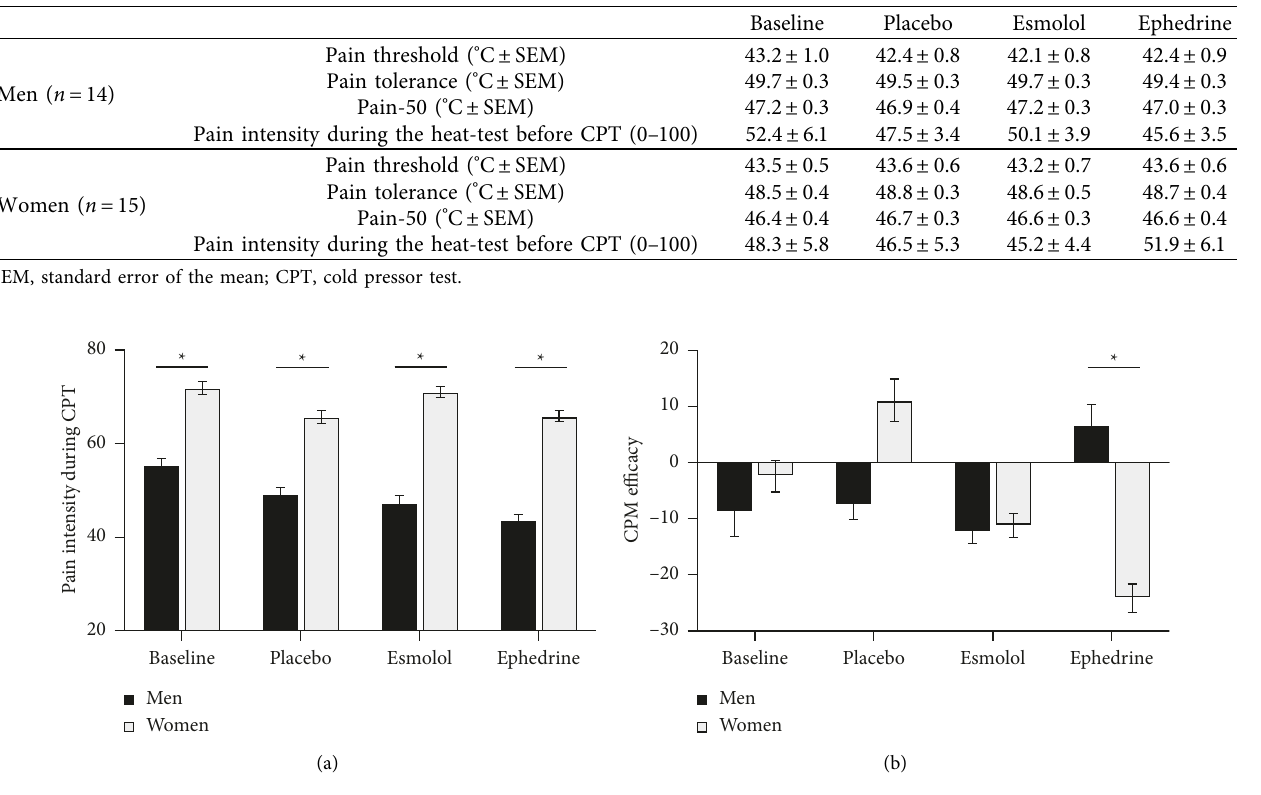
Figure 1: Scores for men and women for the 4 different conditions (baseline, placebo, esmolol, and ephedrine). (a) Mean pain intensity ratings during the cold pressor test (CPT). (b) Mean conditioned pain modulation (CPM) effectiveness. ∗ p < 0 . 05 for the difference between men and women calculated using contrast in the overall mixed model that includes the interaction between condition and sex. Table 3: Mean heart rate for the different conditions in men and women.